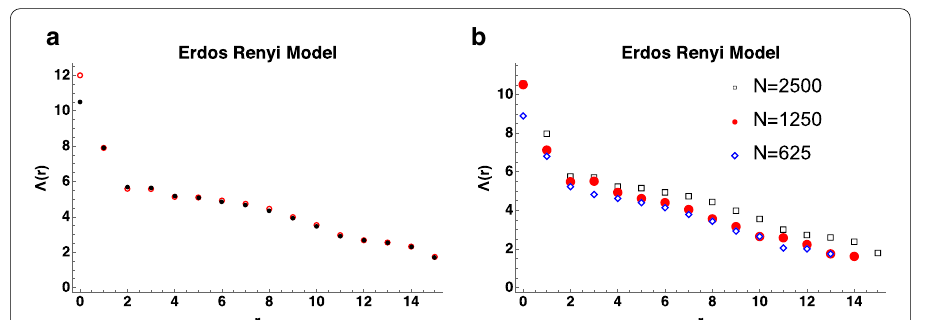
Fig. 3 a Average load �( r ) for nodes at a distance r from the center, from which demand is broadcast, for the 2500. Filled black circles are �( r ) when the demand is the same, 2 / N and N Erdös–Rényi model with p = = irrespective of the destination. Open red circles are 2.5 �( r ) when the demand decreases as ( 1 / 4 ) r of 2.5 is chosen by eye to best match the two cases. The total demand for all destination nodes is normalized to 1. b Average load �( r ) as a function of r for various values of N , for the broadcast model with the same demand for all destination nodes. The difference between the curves is